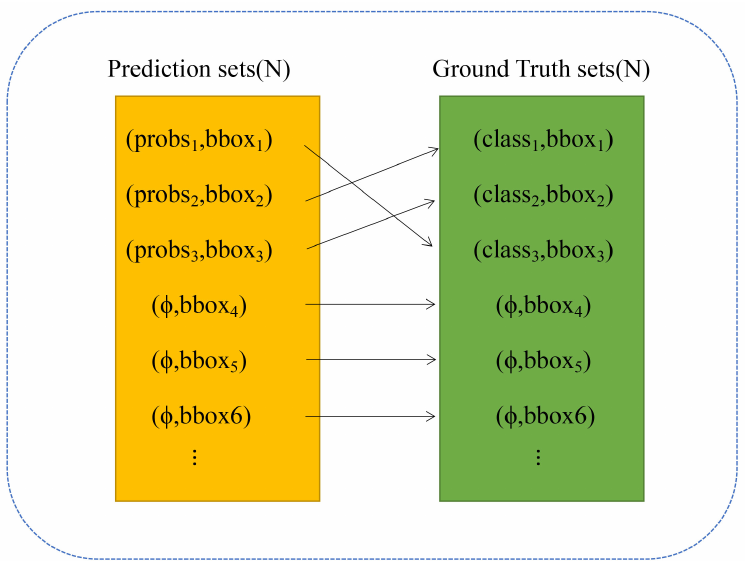
Figure 8. Relations between prediction and ground truth